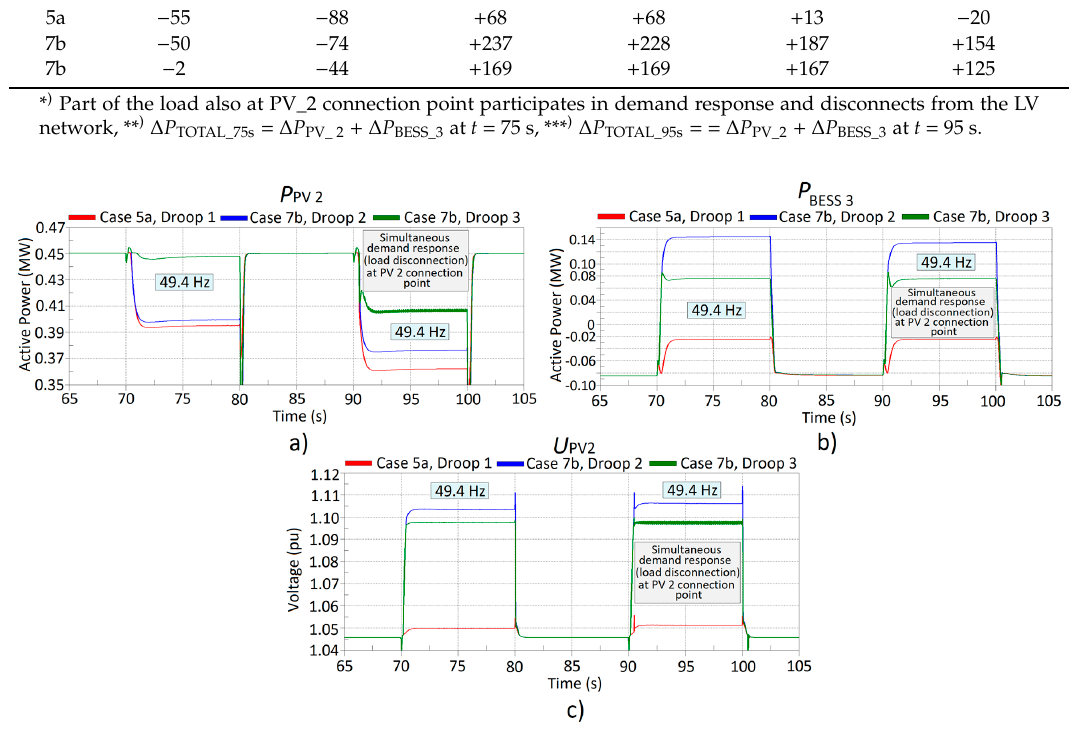
Figure 8. ( a ) PV 2 active power P PV_2 , ( b ) BESS 3 active power P BESS_3 , and ( c ) local voltage U PV_2 behavior at PV 2 connection point during simulated under-frequency (49.4 Hz) events in Cases 5a ( PU -droop 1), 7b ( PU -droop 2), and 7b ( PU -droop 3), see also Figures 2 and 7.